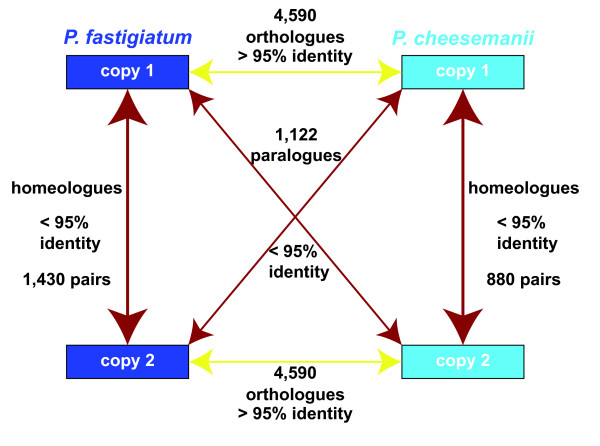
Schematic of homologous sequences within and between P. fastigiatum and P. cheesemanii. Homologous sequences between P. fastigiatum and P. cheesemanii were considered orthologues (4,590 genes) if they were more than 95% identical and paralogues (1,122 genes) elsewise. Homeologues within a species were also less than 95% identical (1,430 and 880 gene pairs).